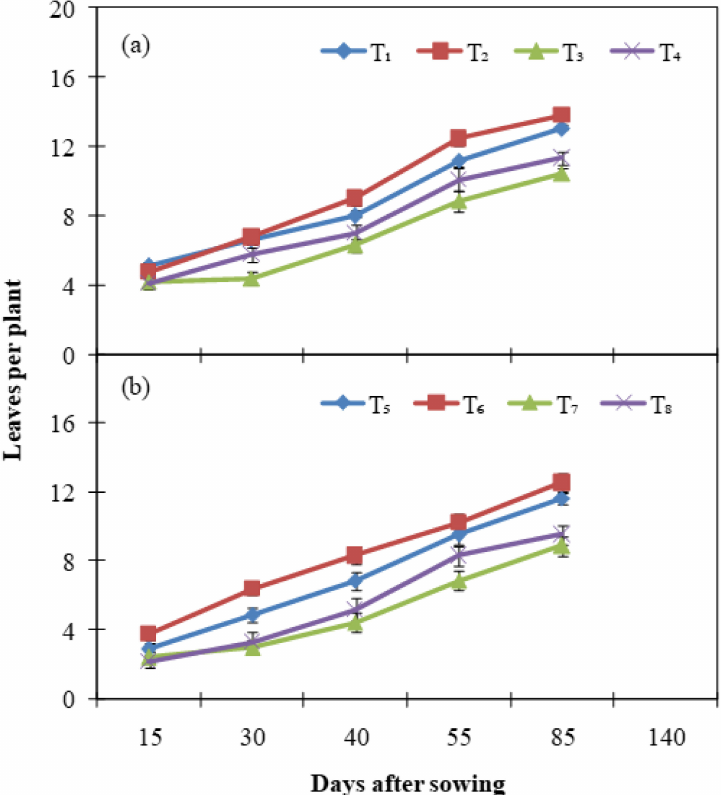
Figure 4. Mean leaves per plant of grain maize crop as affected by irrigation methods (IM), water stress (WS), and mulching practice (MP) under conventional furrow irrigation ( a ) and the alternate furrow irrigation ( b ) method throughout the growing period during 2020–2021. T 1 , T 2 , T 3 , T 4 , T 5 , T 6 , T 7 , and T 8 indicate the combined factor treatments, respectively. The values are means ± SE ( n = 3). The error bars are standard